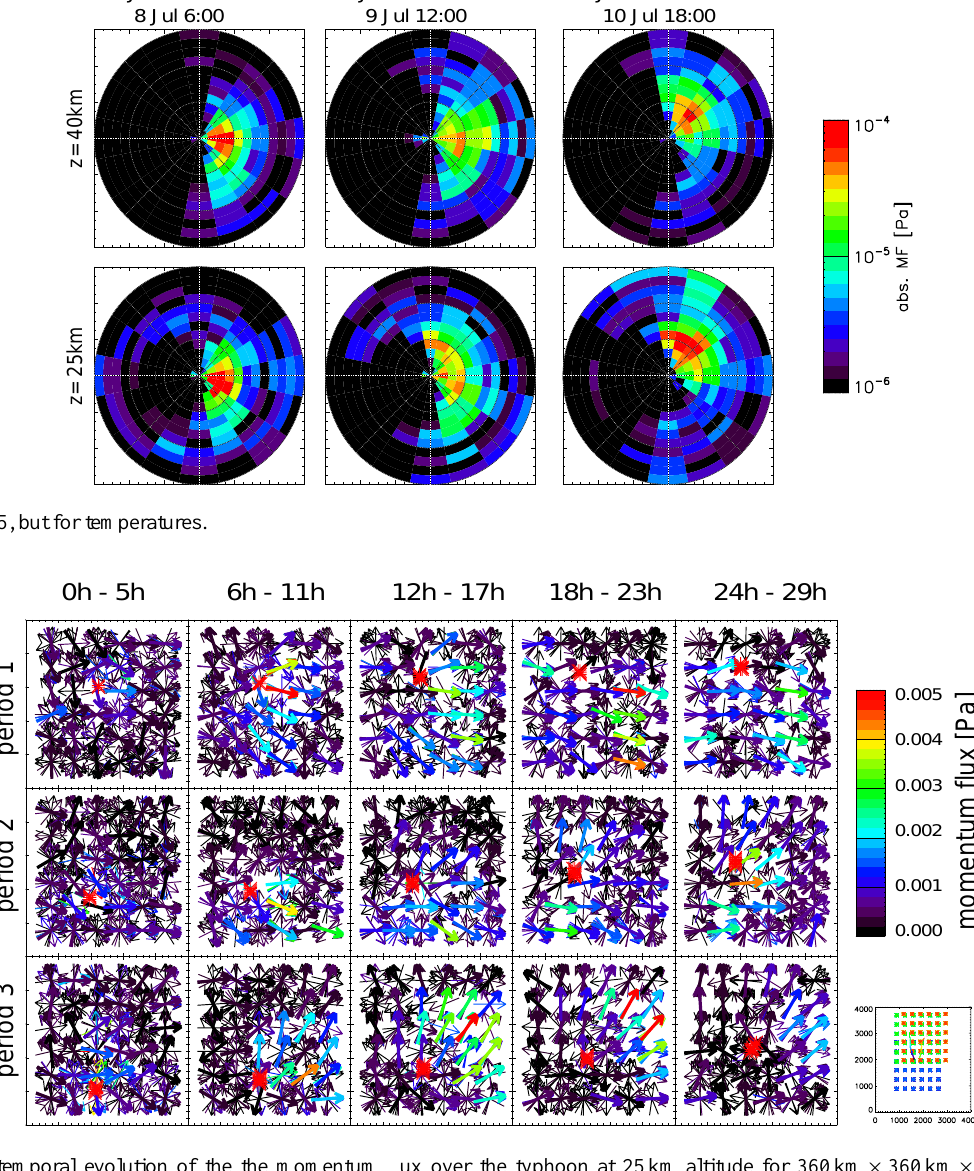
Fig. 7. Spatio-temporal evolution of the the momentum flux over the typhoon at 25km altitude for 360km × 360km × 10km analysis volume. Thin arrows indicate single events and components, thick arrows the average total momentum flux. Each panel shows a six hourly interval, time proceeds from left to right and top to bottom. Please note that the position of a momentum flux value corresponds to the center of an arrow (not the